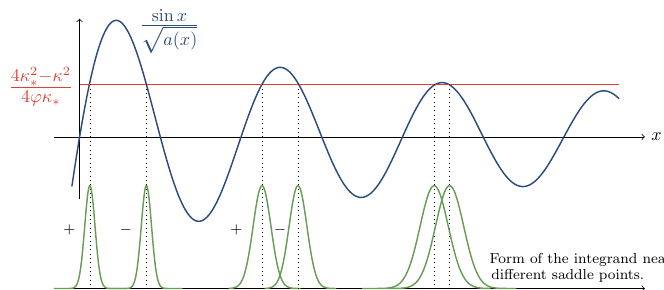
Form of the integrand near different saddle points.